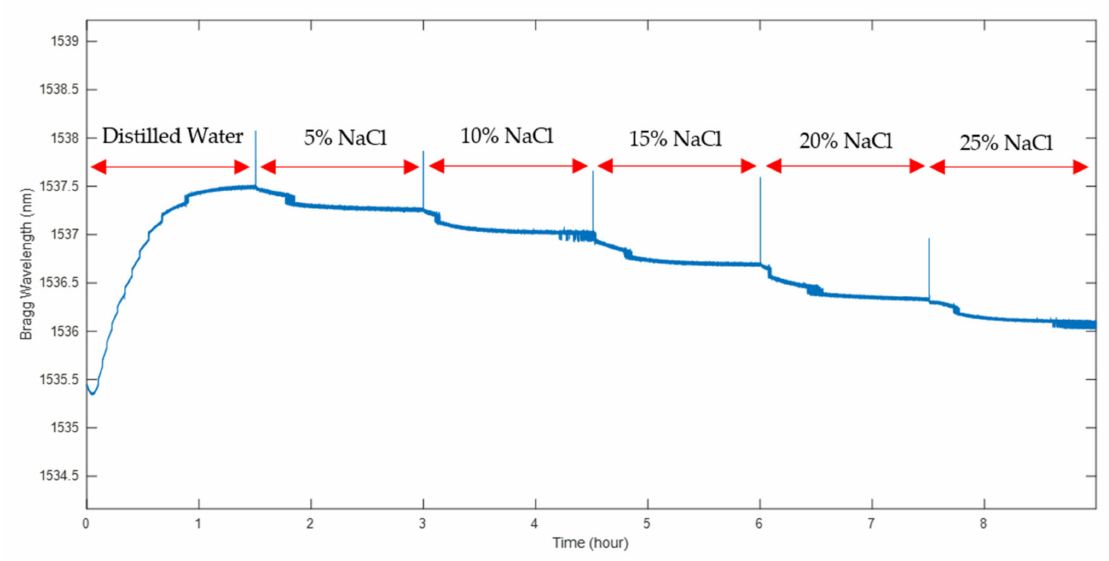
Figure 10. The polymer sensor’s sensitivity to salt concentration changes in water.